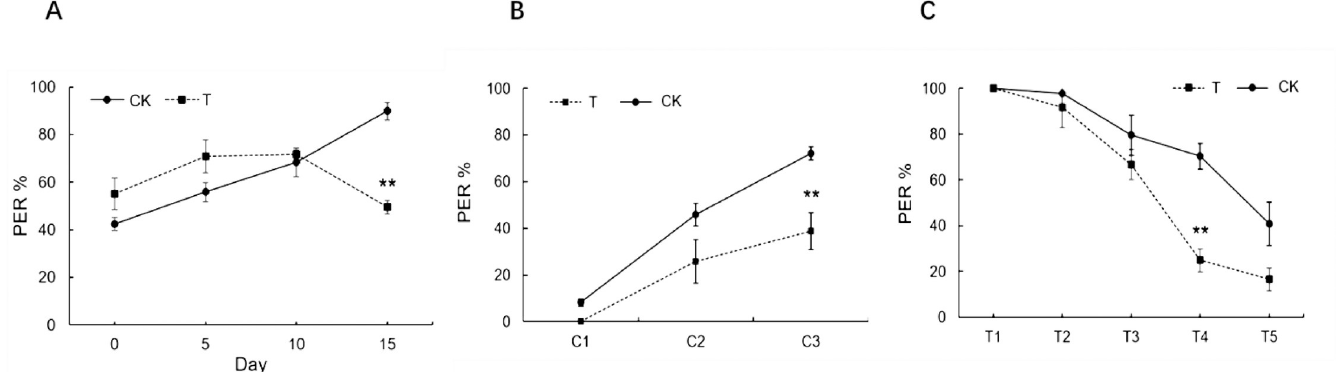
Fig 3. The effect of T . mercedesae infestation on olfactory associated functions of adult honeybee. A. The effect of T . mercedesae infestation on sucrose responsiveness of adult honeybee. Infested and control bees were tested for PER to 30% (w/w) sucrose solutions at 0, 5, 10 and 15 days after emergence. PER rate (%) was significantly lower in infested bees at day 15 than that of control group. 0 day indicates newly emerged adult bees. B. PER responses of infested or non-infested honeybees during the conditioning phase (C1–C3). C. PER responses of infested or non-infested honeybees during the extinction phase (T1–T5). CK: non-infested honey bees; T: T . mercedesae -infested honey bees. Data are means of three independent experiments, and error bars represent ± standard error (SE). Significant differences to CK with P < 0.01 are indicated by asterisks according to chi-squared test.